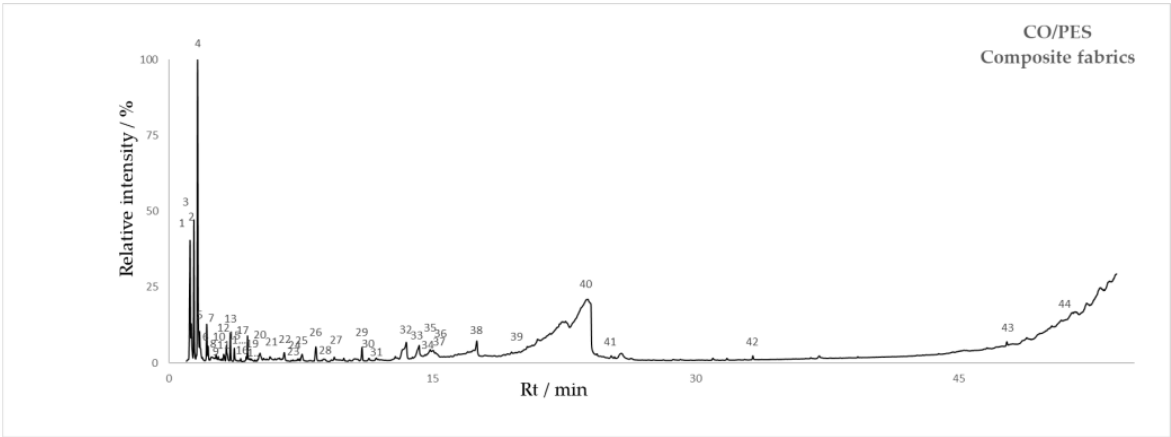
Figure 4. Chromatogram of composite fabric sample.